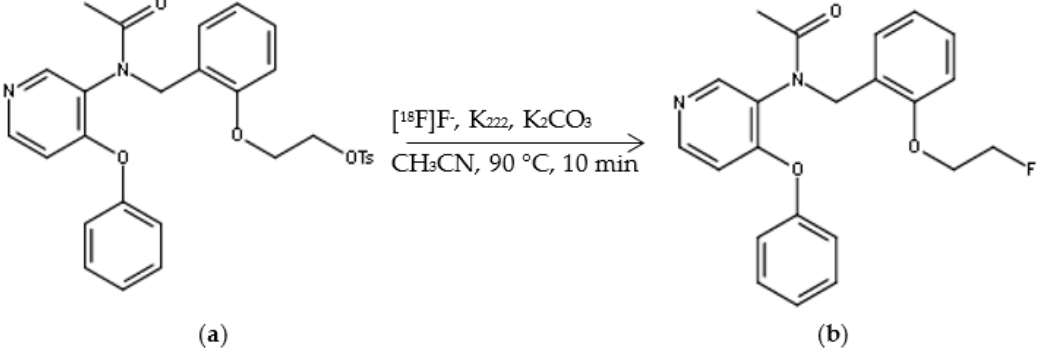
Figure 1. ( a ) FEPPA Precursor (2-(2-((N-4-phenoxypyridin-3-yl)acetamido)methyl)phenoxy)ethyl 4-methylbenzenesulfonate); ( b ) [ 18 F]FEPPA.